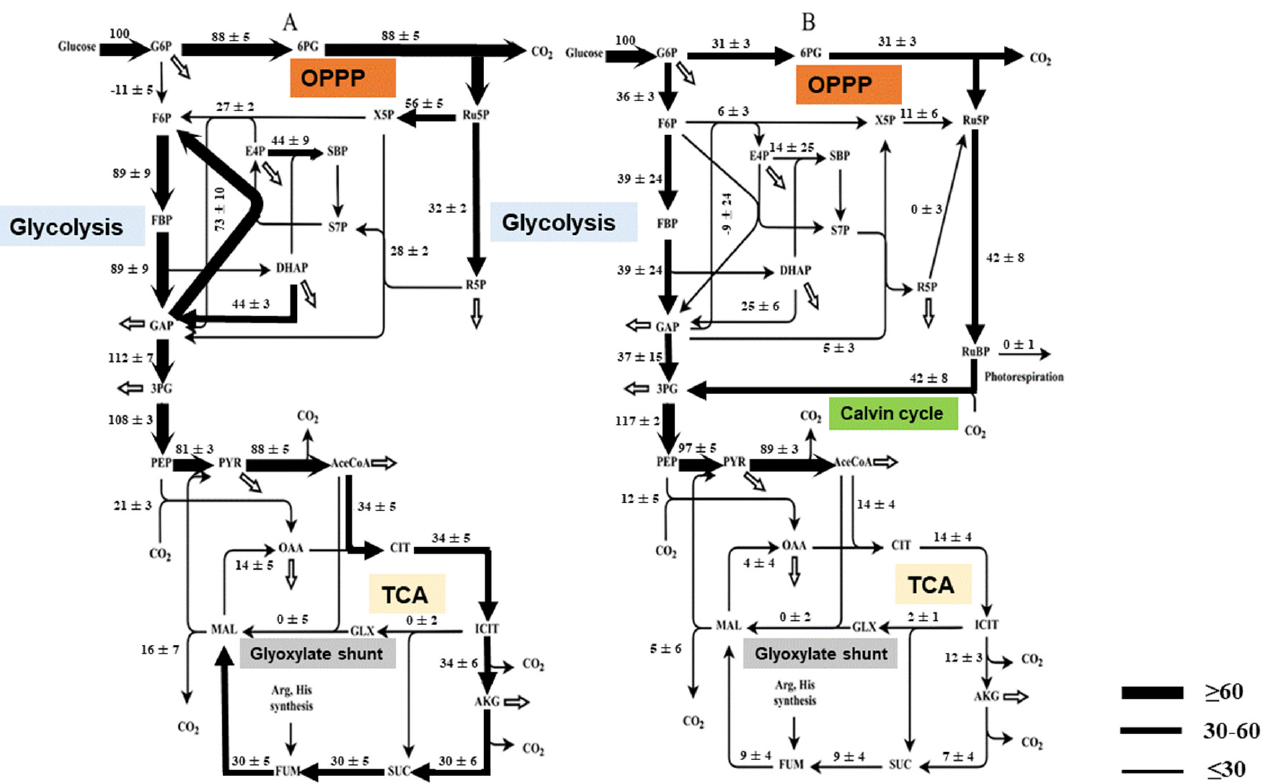
Figure 3. Flux distribution in the central metabolism of C. sorokiniana . ( A ) Heterotrophically cultured C. sorokiniana cells; ( B ) mixotrophically cultured C. sorokiniana cells. All estimated relative flux rates are shown next to the pathways, which are normalized to the glucose uptake rate. The standard deviation of each flux is shown, which was calculated based on the 95% confidence intervals (Supplementary Materials, File S3). The solid arrows represent the directions of the net fluxes and the wider arrows show higher flux rates. The open arrows represent the fluxes to the biomass.